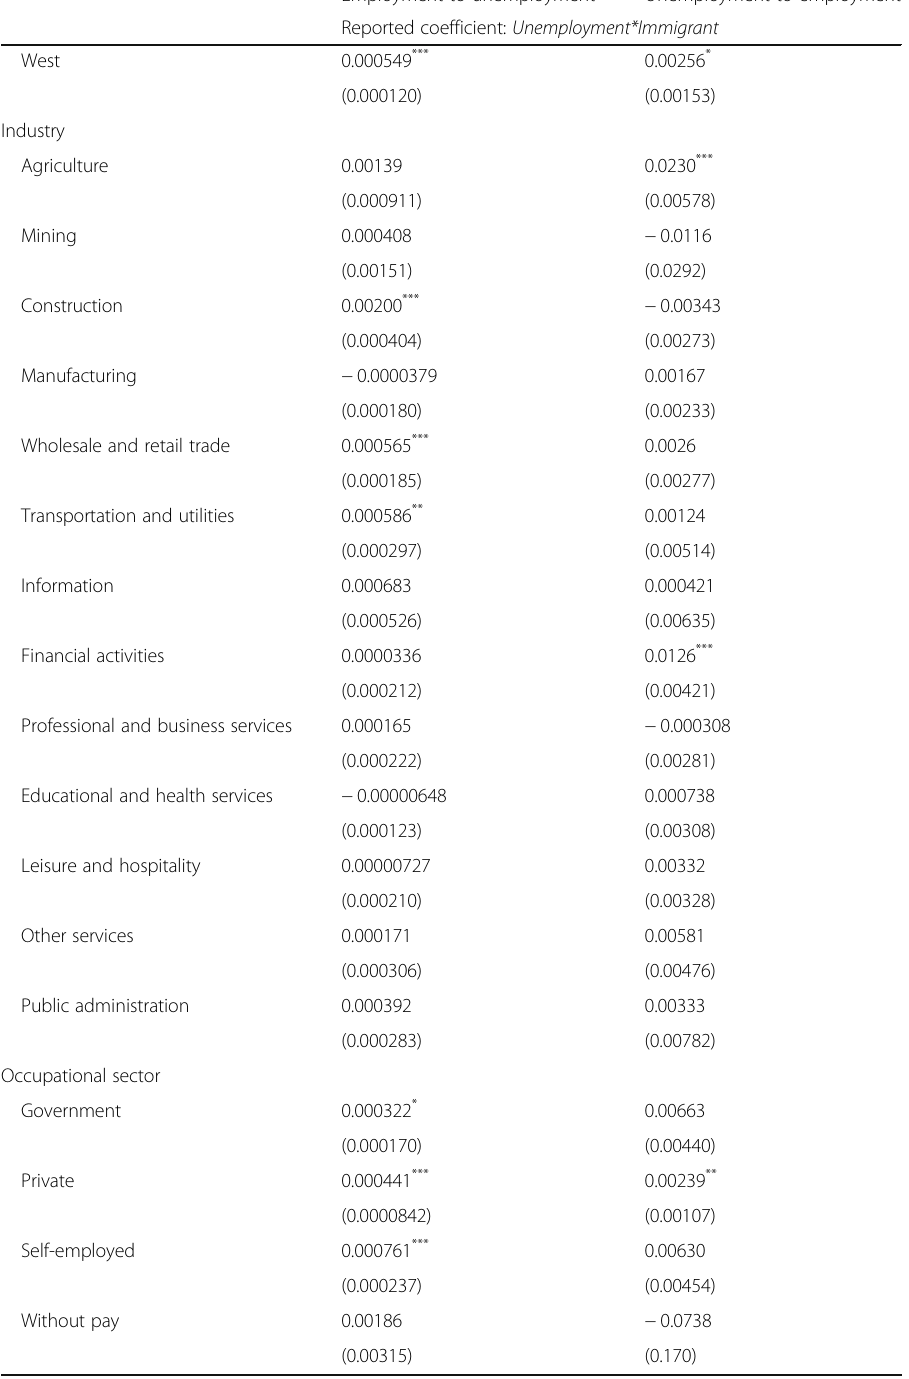
Table 8 Test for heterogeneity based on two-way transitions: matched CPS data, 1996 –